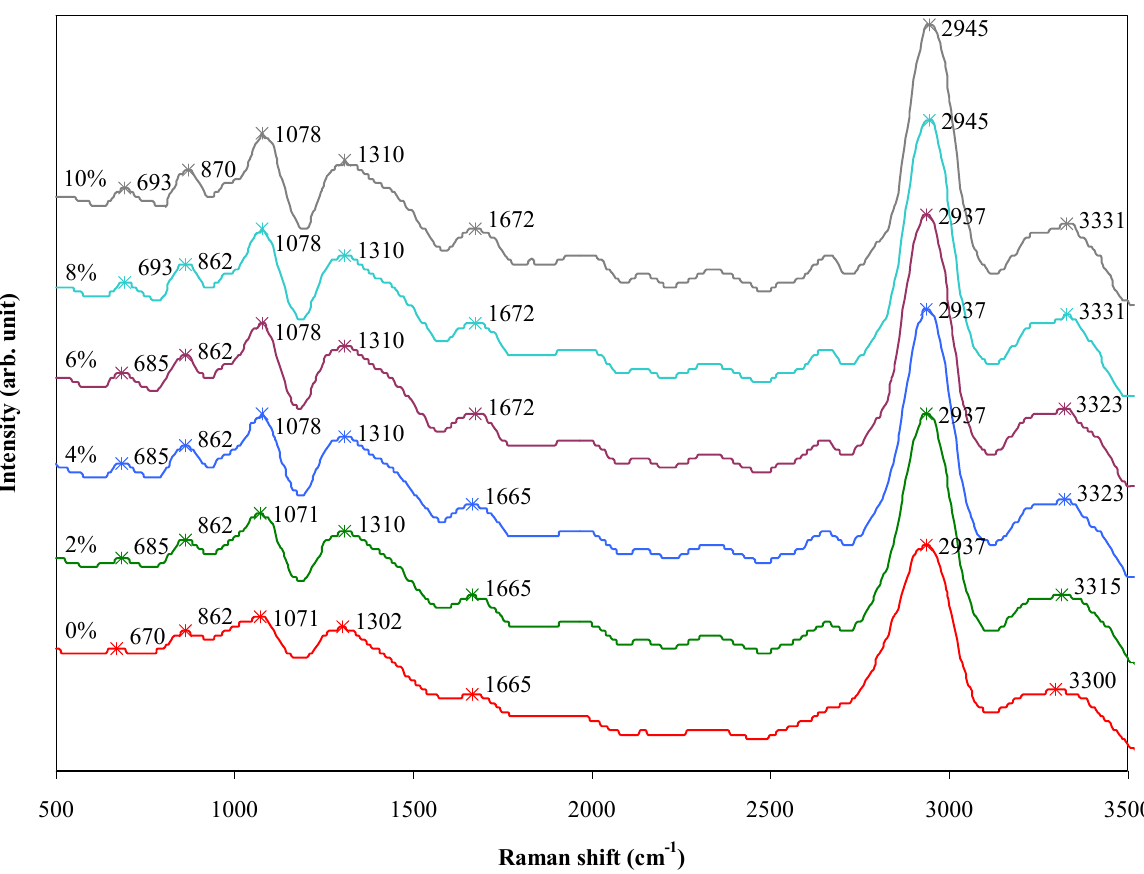
Figure 9. FT-Raman spectra of the agarose/talc composite films containing different amount of BmimCl/Urea.